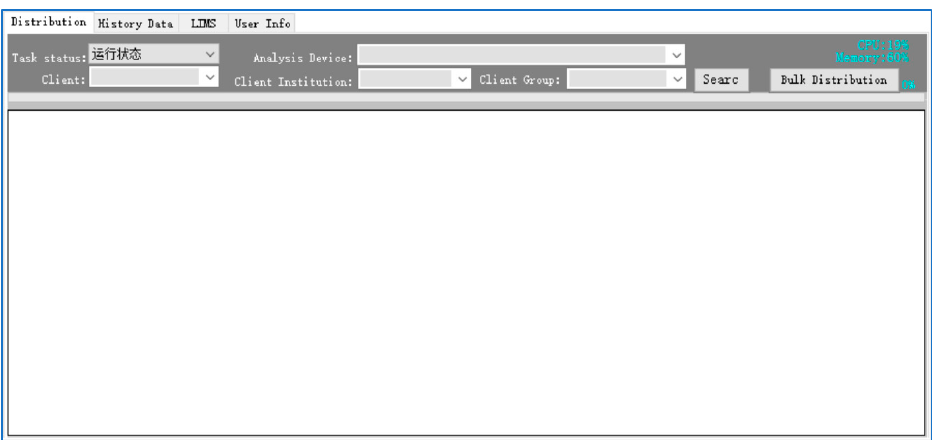
Figure 8. Data Manage and Distribute module interface.